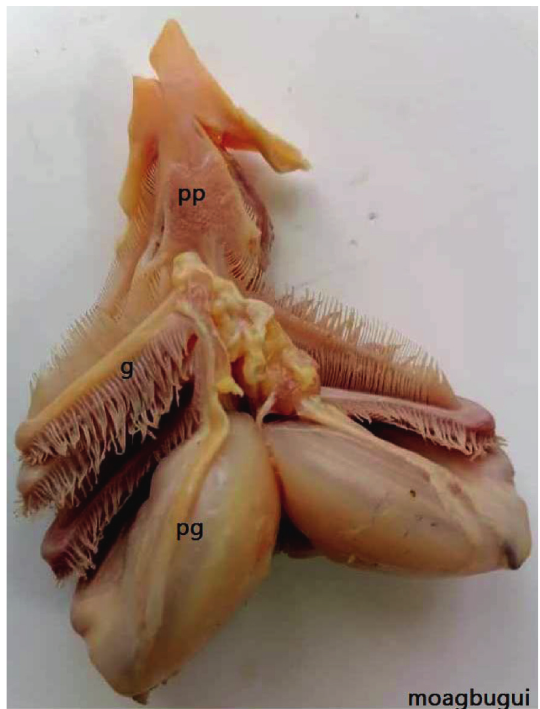
Figure 5: Gill of H. niloticus . pp, pharyngeal figure showing teeth; g, gills; pg, pouch of gills.